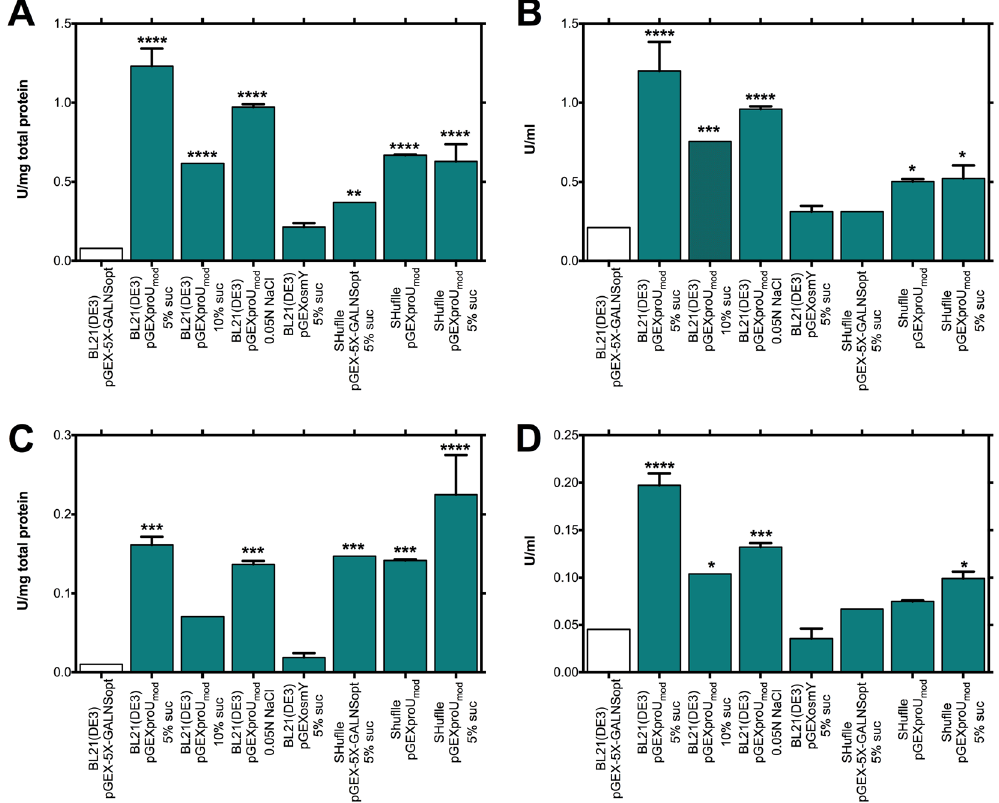
Figure 6. Production of rhGALNS in E. coli using the combinations of the different studied approaches. ( A ) Specific activity in the extracellular fraction. ( B ) Volumetric activity in the extracellular fraction. ( C ) Specific activity in the intracellular fraction. ( D ) Volumetric activity in the intracellular fraction. Enzyme activity was assessed 24 hours after induction (no induction was necessary in the case of the promoter proU mod ). A Student’s t-test was performed to assess significance, where ( * ) corresponds to a p-value < 0.05, ( ** ) p-value < 0.01, ( *** ) p-value < 0.001 and ( **** ) p-value < 0.0001. Specific activities are expressed as U rhGALNS/(mg total protein) and volumetric activities as U/ml.